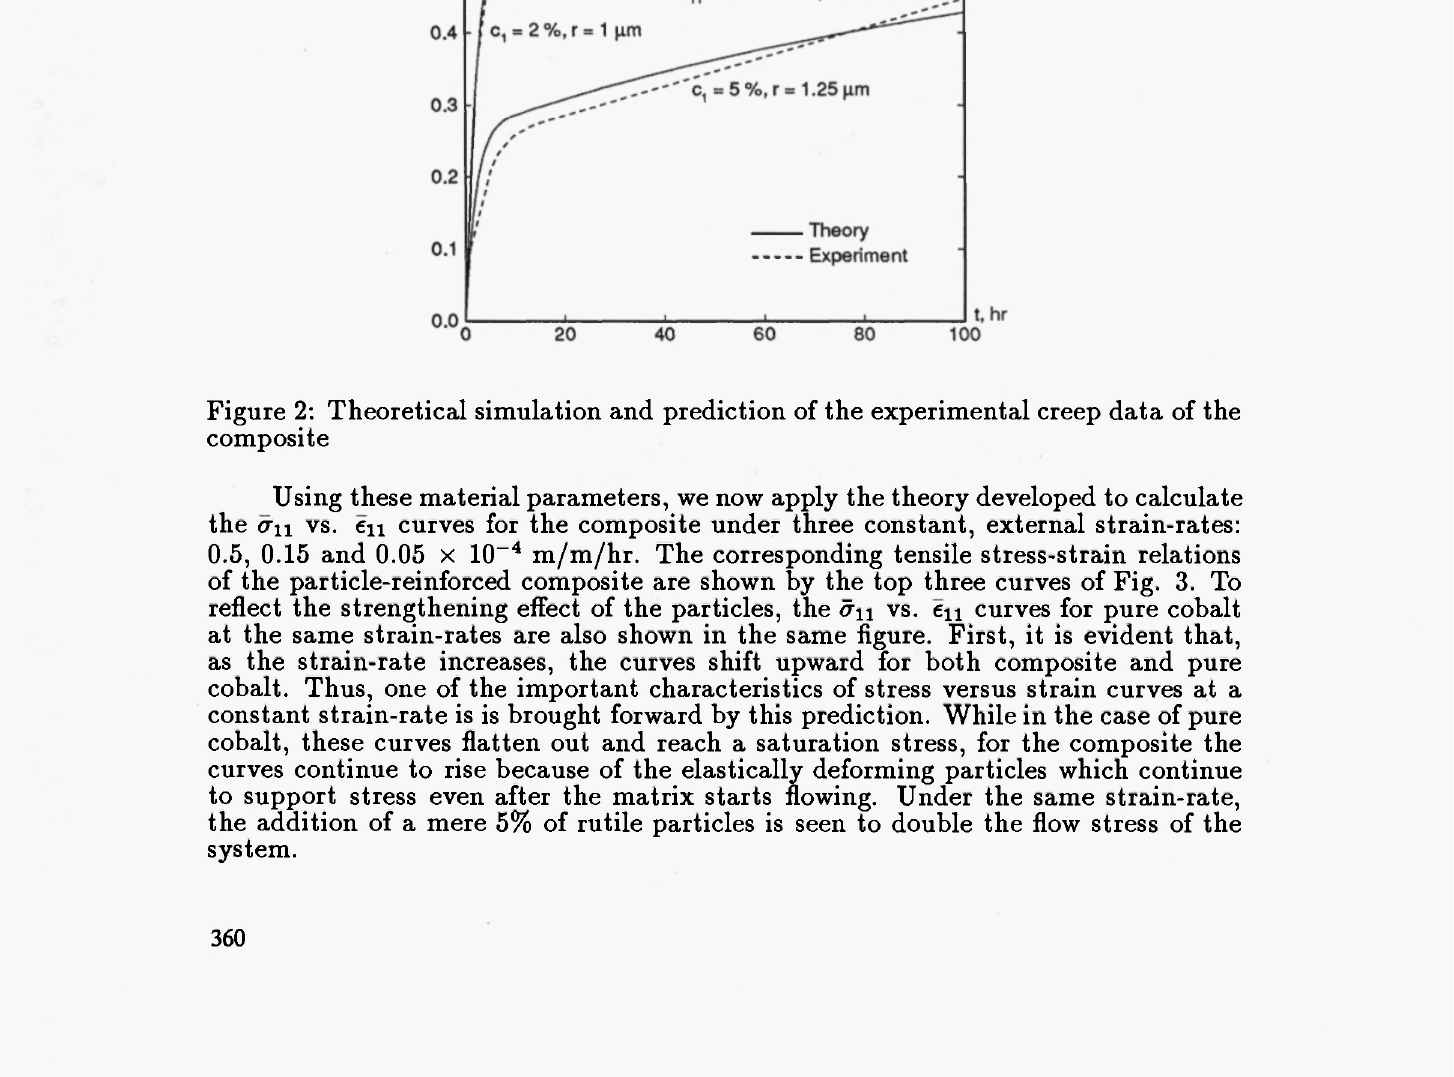
Figure 1: Theoretical simulation of the experimental creep data of pure cobalt